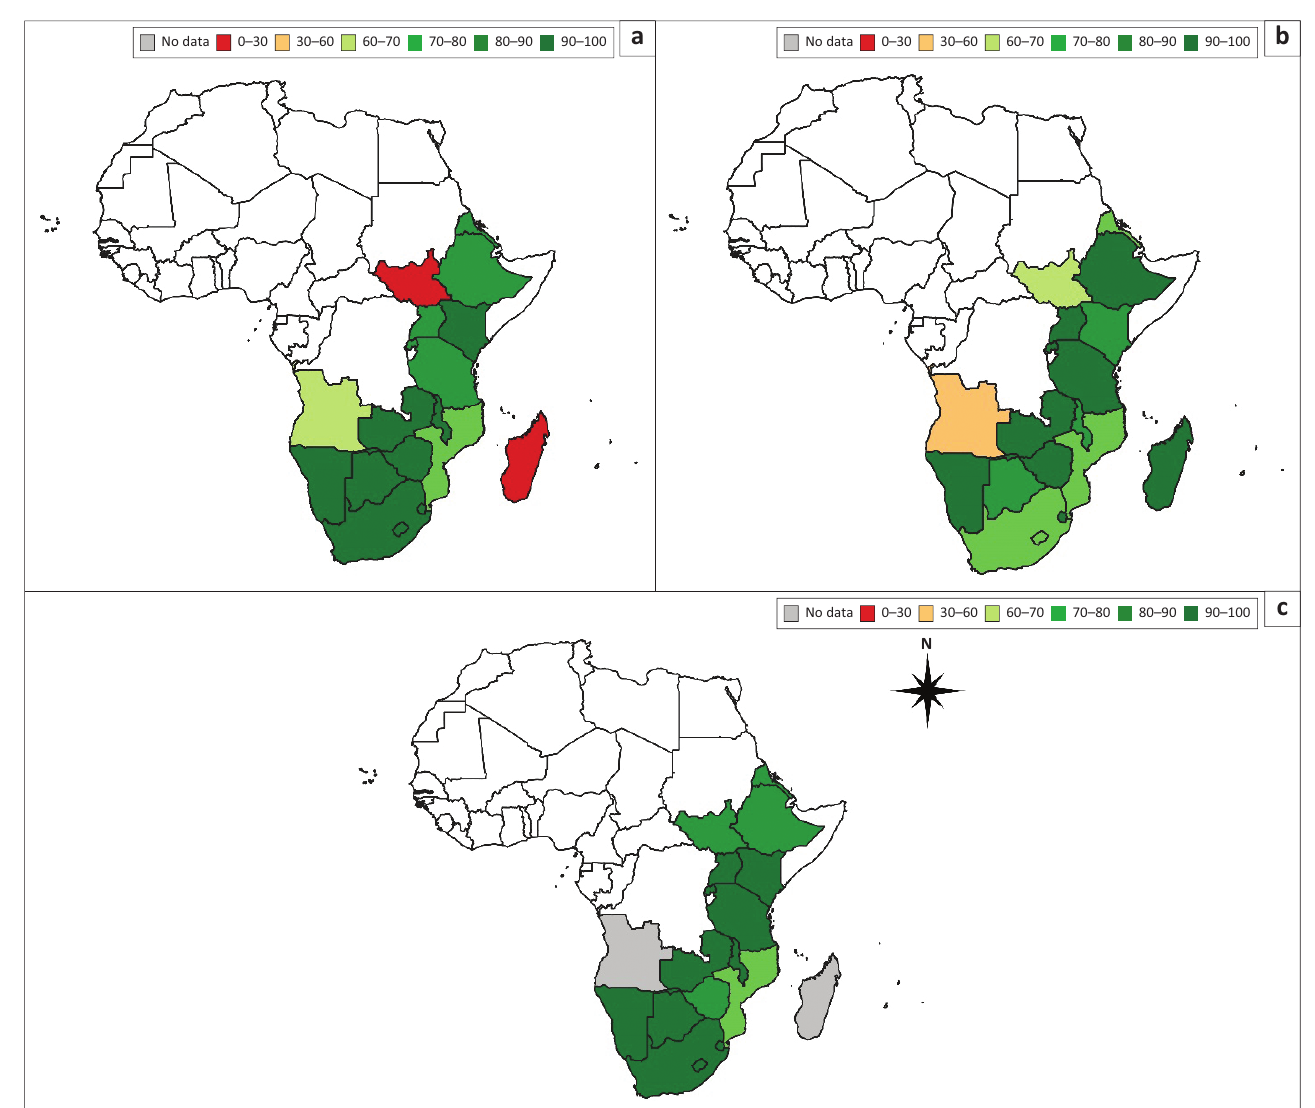
FIGURE 2: Data on the ESA 90-90-90 goals in all ages by country from the UNAIDS data 2020 report. 10 (a) First 90; (b) second 90; (c) third 90.